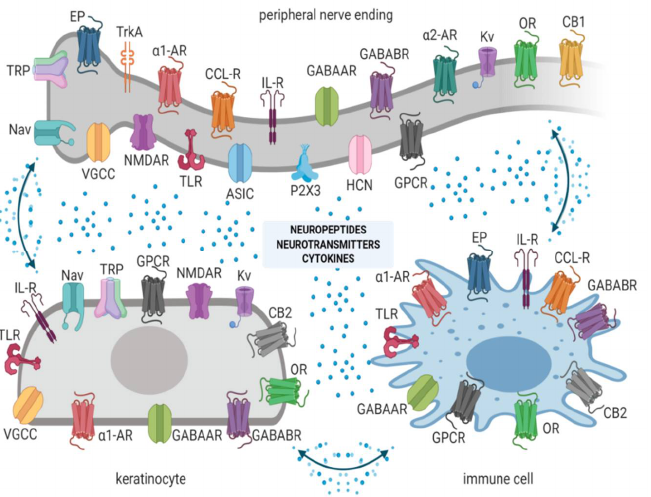
Figure 1. Peripheral nerve endings, keratinocytes, and immune cells express ion channels and receptors and release numerous signaling molecules to create a complex interaction, involved in physiological nociception and neuropathic pain (NP) generation. Abbreviations: Nav—voltage-gated sodium channels, TRP—transient receptor potential channels, VGCCs—voltage-gated calcium channels, NMDAR—N-methyl-D-aspartate receptors, ASIC—acid-sensing ion channels, TLR—Toll-like receptors, α1-AR—α1 adreno receptors, α2-AR—α2 adreno receptors, EP—prostaglandin E2 receptors, GABAAR—gamma-aminobutyric acid receptors A, GABABR— gamma-aminobutyric acid receptors B, Kv—voltage-gated potassium channels, OR—opioid receptors, CB1, CB2—cannabinoid receptors type 1 or 2, CCL-R—chemokine receptors, IL-R—interleukin receptors, TrkA—tropomyosin receptor kinase A, HCN—hyperpolarization-activated cyclic nucleotide-gated channels, P2X3—P2X purinoceptors 3, GPCR—G protein-coupled receptors, TLR—Toll-like receptors. Created with BioRender.com.